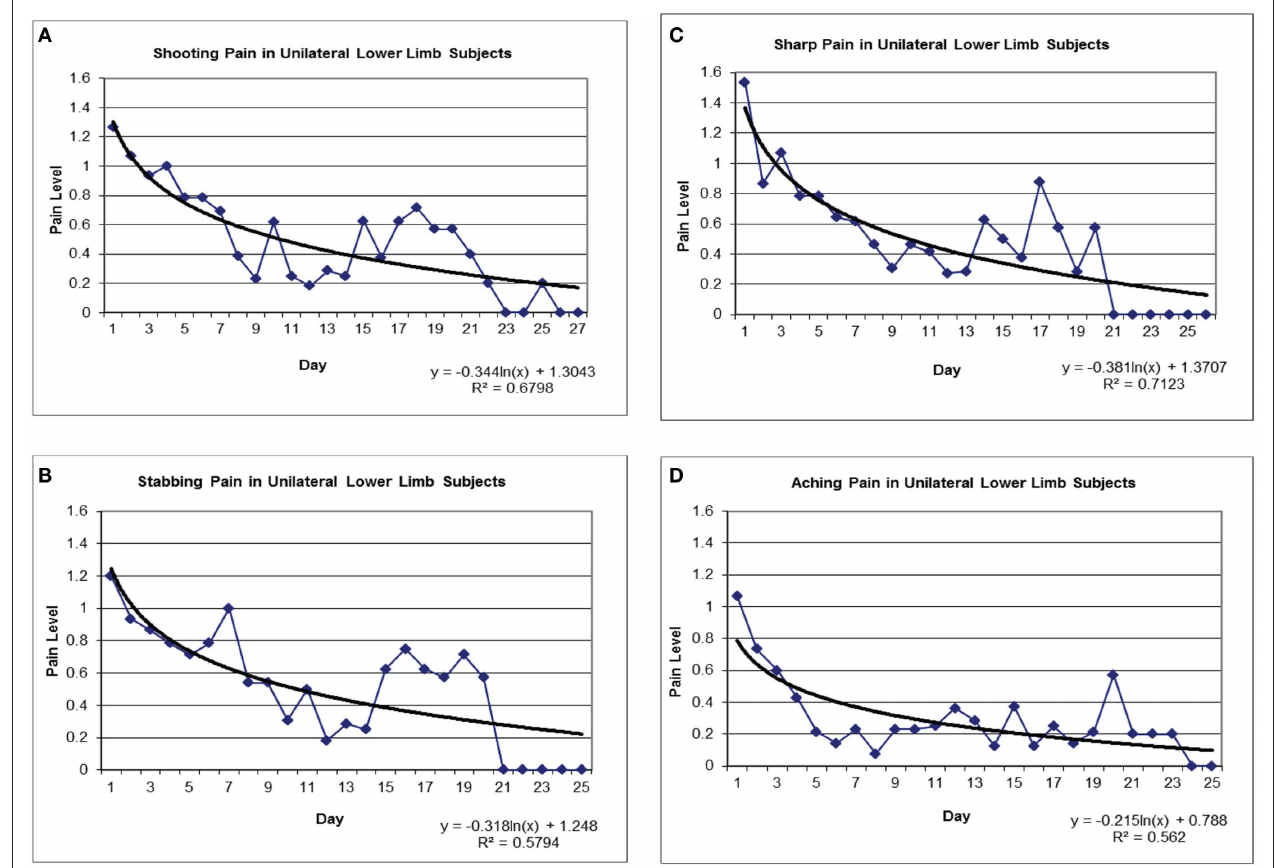
FiguRE 4 | Treatment effect for shooting pain (A), stabbing pain (B), sharp pain (C), and aching pain (D).